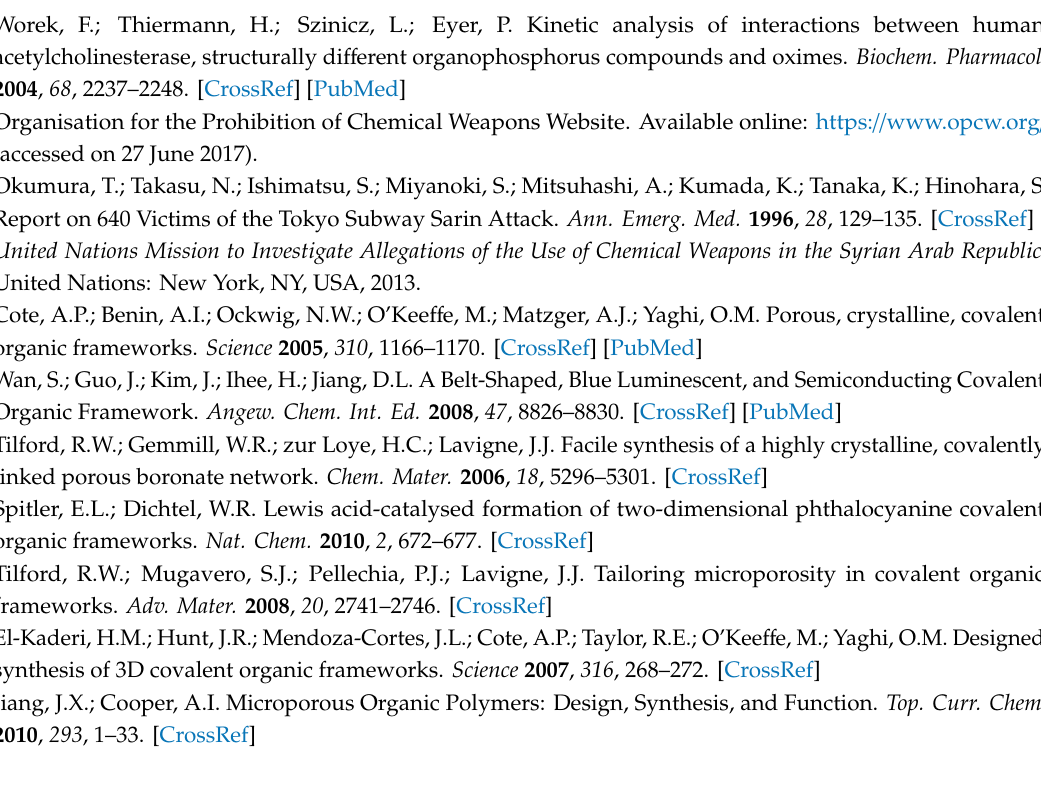
Supplementary Materials: The following are available online at http: // www.mdpi.com / 1996-1944 / 12 / 12 / 1974 / s1, Figure S1: FTIR (ATR) spectrum of [HC ≡ C] 0.5 -TPB-DMTP-COF , Figure S2: FTIR (ATR) spectrum of [( S )-Py] 0.5 -TPB-DMTP-COF , Figure S3: FTIR (ATR) spectrum of 2-step-[( S )-PyMe] 0.5 -TPB-DMTP-COF , Figure S4: FTIR (ATR) spectrum of 2-step-[( S )-PyMe] 0.5 -TPB-DMTP-COF , Figure S5: FTIR (ATR) spectrum of [( S )-PyMe] 0.5 -TPB-DMTP-Polym , Figure S6: 13 C CP / MAS NMR of [HC ≡ C] 0.5 -TPB-DMTP-COF , Figure S7: 13 C CP / MAS NMR of [( S )-Py] 0.5 -TPB-DMTP-COF , Figure S8: 13 C CP / MAS NMR of 2-step-[( S )-PyMe] 0.5 -TPB-DMTP-COF , Figure S9: 13 C CP / MAS NMR of 1-step-[( S )-PyMe] 0.5 -TPB-DMTP-COF , Figure S10: PXRD of 1-step-[( S )-PyMe] 0.5 -TPB-DMTP-COF (blue), 2-step-[( S )-PyMe] 0.5 -TPB-DMTP-COF (purple) and [( S )-PyMe] 0.5 -TPB-DMTP-Polym (green), Figure S11: N 2 (77 K) adsorption isotherms for 1-step-[( S )-PyMe] 0.5 -TPB-DMTP-COF (blue), 2-step-[( S )-PyMe] 0.5 -TPB-DMTP-COF (purple) and [( S )-PyMe] 0.5 -TPB-DMTP-Polym (green), Figure S12: NLDFT pore size distribution for the essayed COF materials [HC ≡ C] 0.5 -TPB-DMTP-COF (a), [( S )-Py] 0.5 -TPB-DMTP-COF (b), 2-step-[( S )-PyMe] 0.5 -TPB-DMTP-COF (c) and 1-step-[( S )-PyMe] 0.5 -TPB-DMTP-COF (d), Figure S13: CO 2 (298 K) adsorption isotherms for [HC ≡ C] 0.5 -TPB-DMTP-COF (black), [( S )-Py] 0.5 -TPB-DMTP-COF (red) and [( S )-PyMe] 0.5 -TPB-DMTP-COF (blue), Figure S14: SEM image of [( S )-Py] 0.5 -TPB-DMTP-COF , Figure S15: SEM image of 2-step-[( S )-PyMe] 0.5 -TPB-DMTP-COF , Figure S16: SEM image of 1-step-[( S )-PyMe] 0.5 -TPB-DMTP-COF , Figure S17: TGA profile of [HC ≡ C] 0.5 -TPB-DMTP-COF , Figure S18: TGA profile of [( S )-Py] 0.5 -TPB-DMTP-COF , Figure S19: TGA profile of 2-step-[( S )-PyMe] 0.5 -TPB-DMTP-COF , Figure S20: TGA profile of 1-step-[( S )-PyMe] 0.5 -TPB-DMTP-COF , Figure S21: TGA profile of [( S )-PyMe] 0.5 -TPB-DMTP-Polym , Figure S22: E ff ect of DIFP of addition to the essayed COF materials suspension on the pH and color in both bu ff er and unbu ff ered conditions, Figure S23: DIFP degradation studies in basic N -ethylmorpholine bu ff ered media (pH = 9.2). Reaction profiles for 1-step-[( S )-PyMe] 0.5 -TPB-DMTP-COF (blue) and [( S )-PyMe] 0.5 -TPB-DMTP-Polym (green), Table S1: Lattice parameters of the synthesized COFs, Table S2: Summary of textural properties of COF materials from N 2 adsorption measurements at 77 K, Table S3: Catalytic degradation of diisopropylfluorophosphate (DIFP) nerve agent